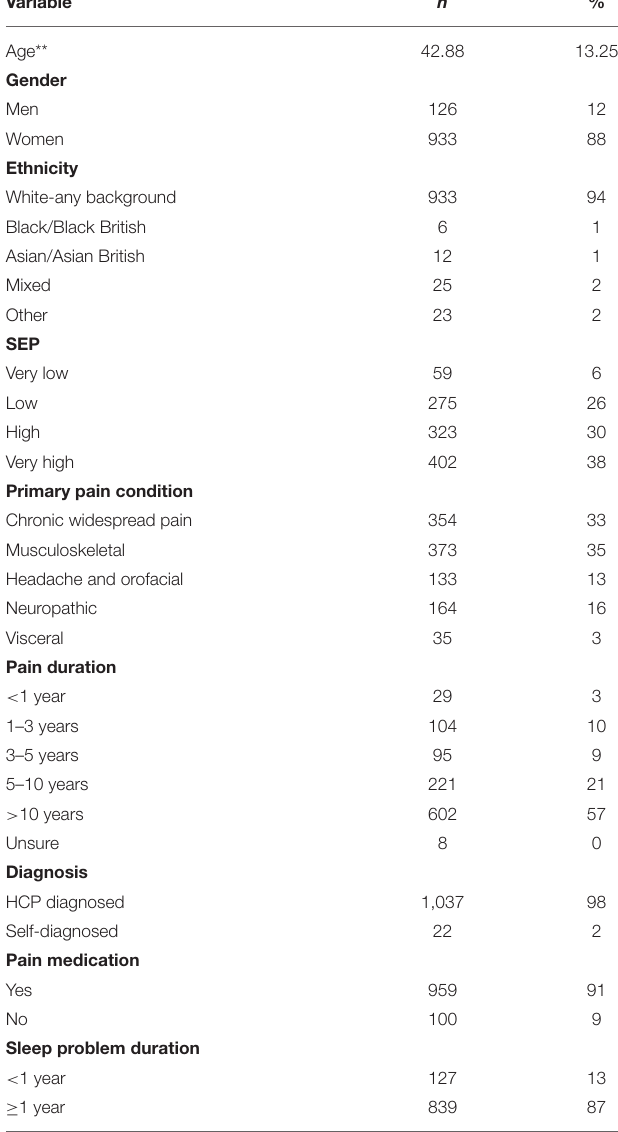
TABLE 1 | Participant